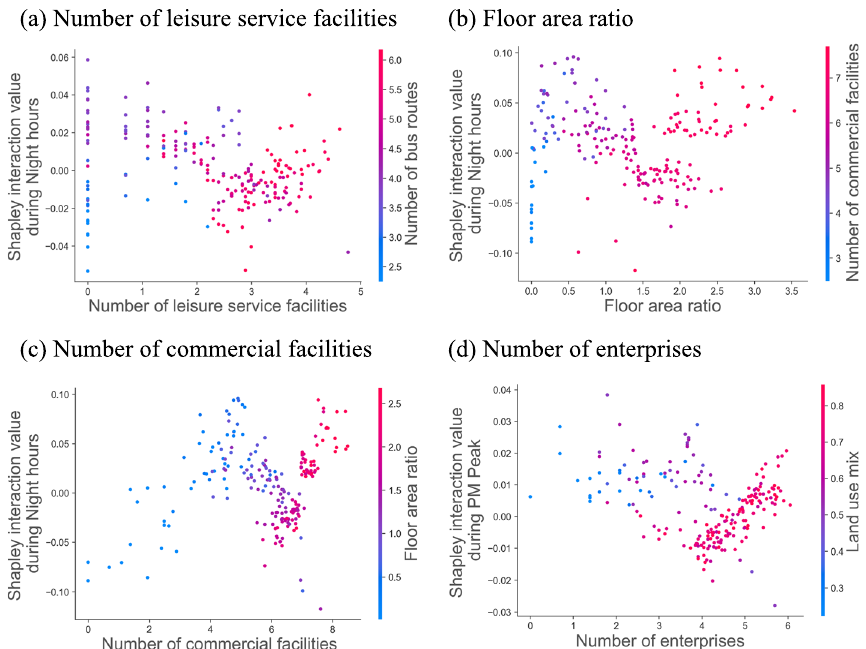
Fig. 6 Local interaction effects among built-environment